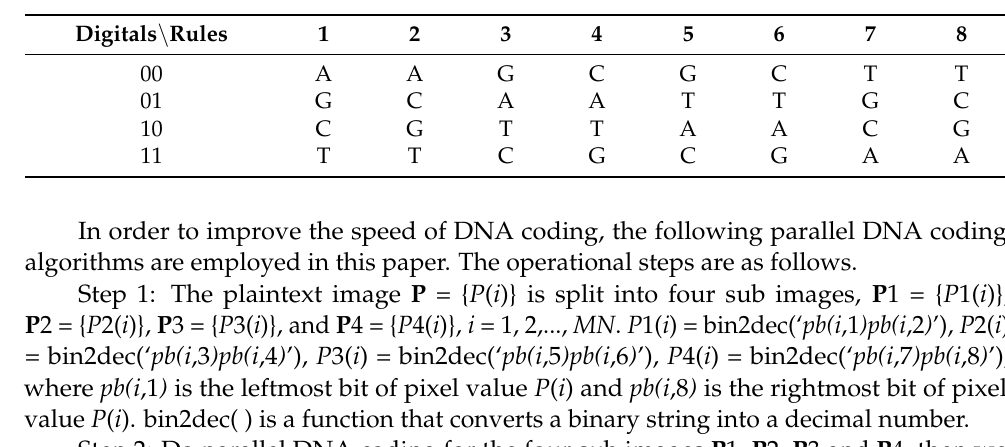
Table 2. DNA coding